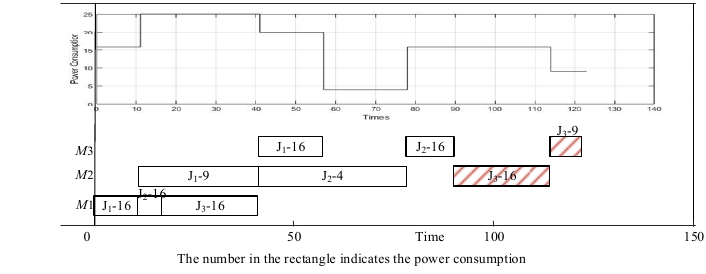
Fig. 2. Gantt Chart for a solution to an example with peak power consumption constraint